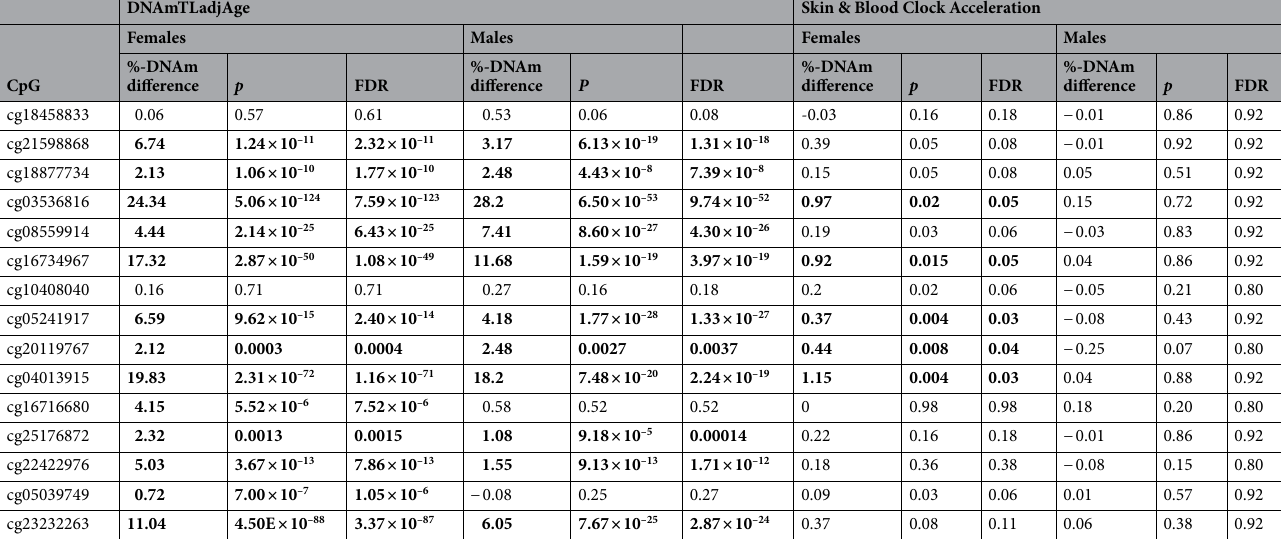
Table 3. *Differences in %-DNAm of the ACE2 gene in nasal cells by estimated age-adjusted DNA methylation telomere length residuals (DNAmTLAdjAge) and epigenetic age acceleration of the skin and blood clock stratified by sex. Bold values indicate FDR <0.05. *Adjusted for